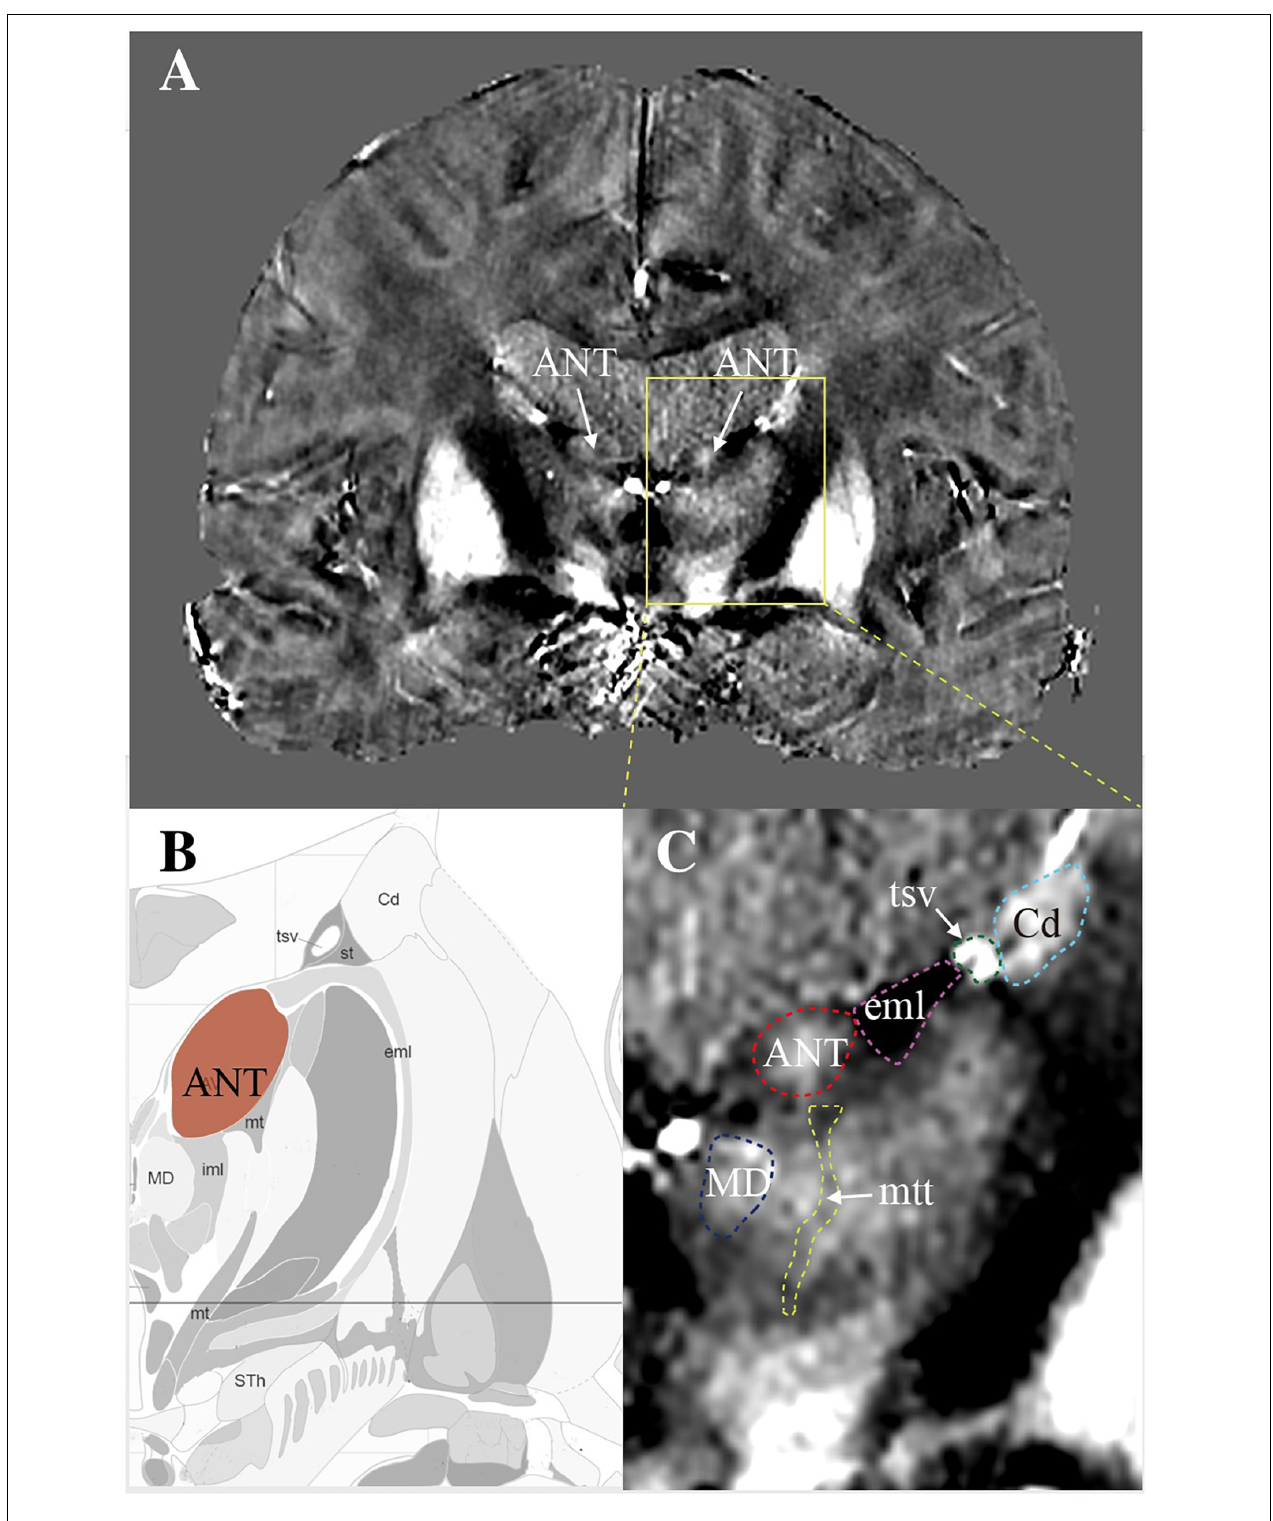
FIGURE 1 | The visualization of ANT on quantitative susceptibility mapping (QSM). (A) A coronal view of a slice from QSM to show bilateral ANTs (white arrows) with its surrounding structures. (B) A map created according to the image section from the Atlas of the Human Brain in Stereotaxic (MNI) Space (MNI: -13.99). (C) Enlarged view of ANT with its surrounding structures. ANT, anterior nucleus of the thalamus; eml, external medullary lamina; mtt, mammillothalamic tract; tsv, thalamostriate vein; Cd, caudate nuclei; MD, mediodorsal nucleus.